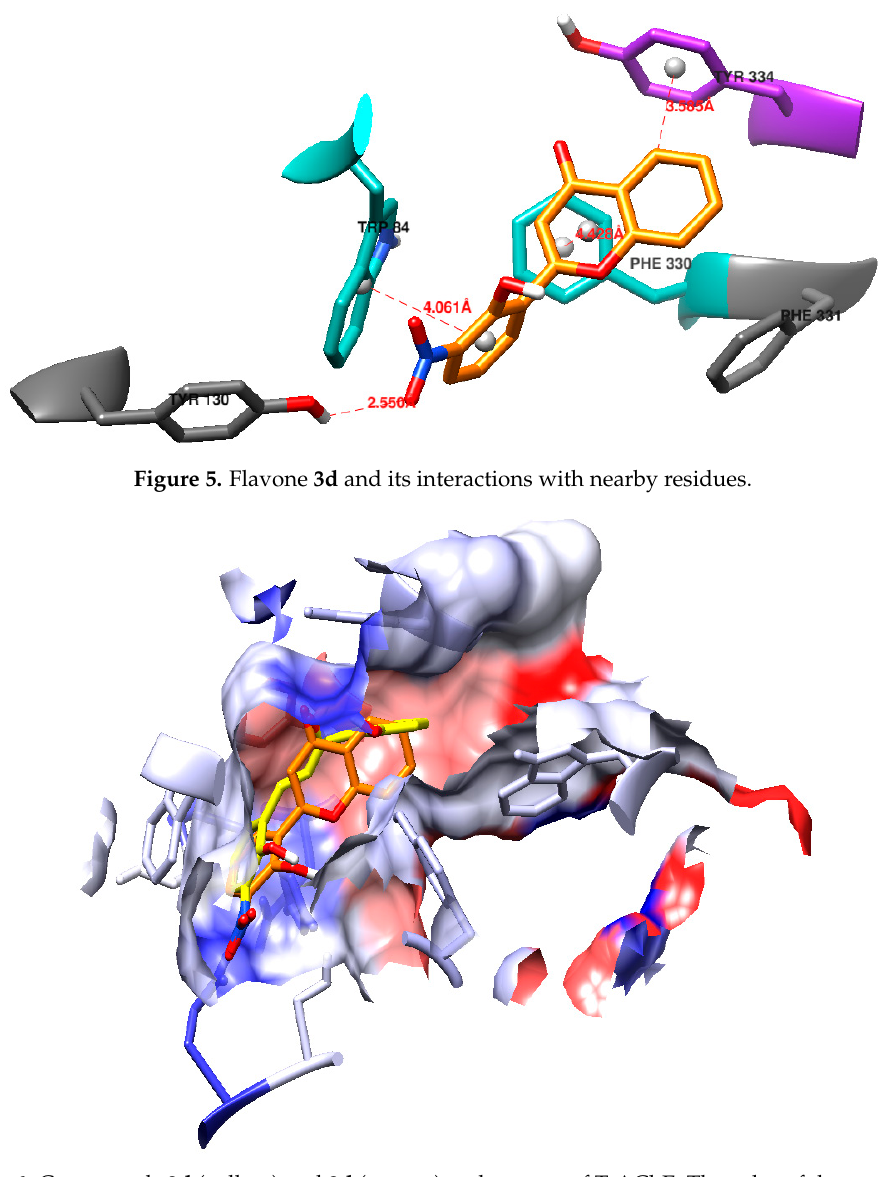
Figure 6. Compounds 2d (yellow) and 3d (orange) at the gorge of TcAChE. The color of the surface of the receptor indicates hydrophilicity (blue) passing by white to red (hydrophobicity).